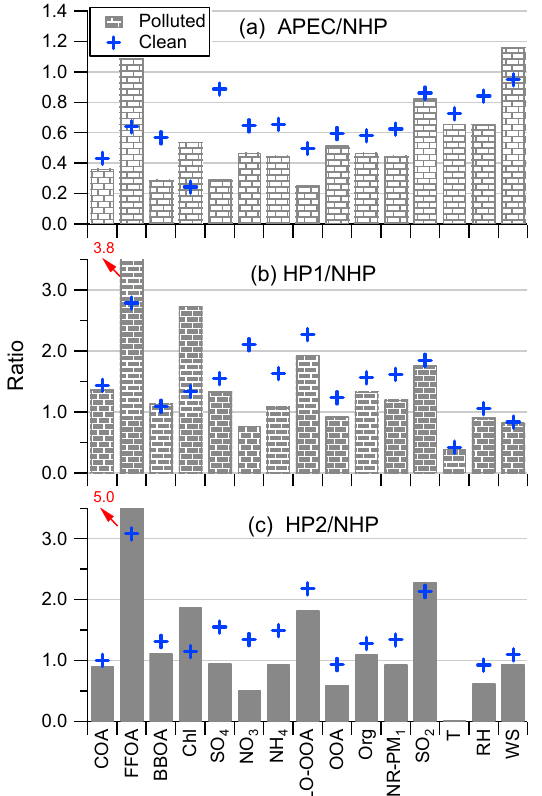
Figure 11. Comparisons of aerosol compositions, gaseous precur- sors, OA factors, and meteorological variables between (a) APEC and NHP, (b) HP1 and NHP, and (c) HP2 and NHP. All the data were separated into the clean events and pollution episodes that are marked in Fig.